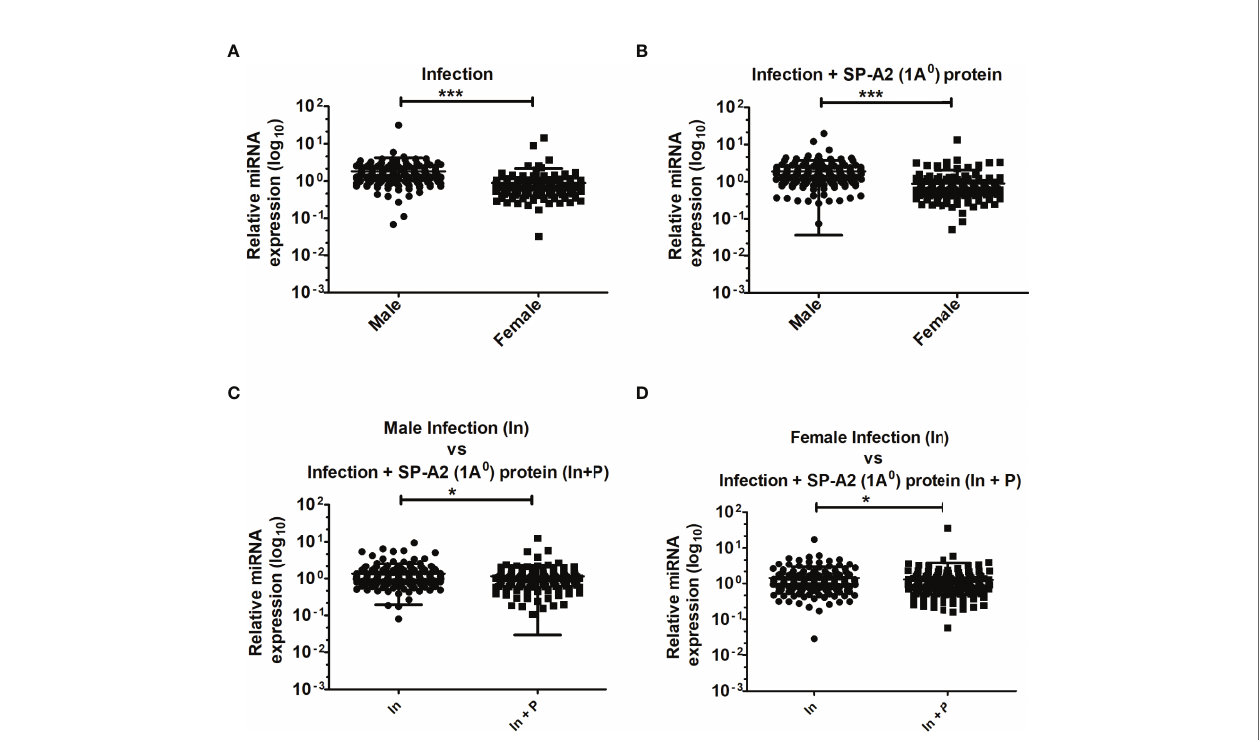
FIGURE 1 | LAC miRNome in KO males and females mice after K . pneumoniae infection and infection plus SP-A2 (1A 0 ) protein rescue. Comparisons between miRNAs identi fi ed in KO, M vs. F, after infection (A) , M vs. F, after infection plus SP-A2 (1A 0 ) protein rescue (B) . Male mice: infection vs. infection plus SP-A2 (1A 0 ) protein (C) . Female mice: infection vs. infection plus SP-A2 (1A 0 ) protein (D) . Signi fi cant differences were observed between sexes and between bacterial infection and infection plus rescue ( A – D ; p < 0.05). *p < 0.05, ***p < 0.001. In; Infection, In + P; infection plus SP-A2 (1A0)